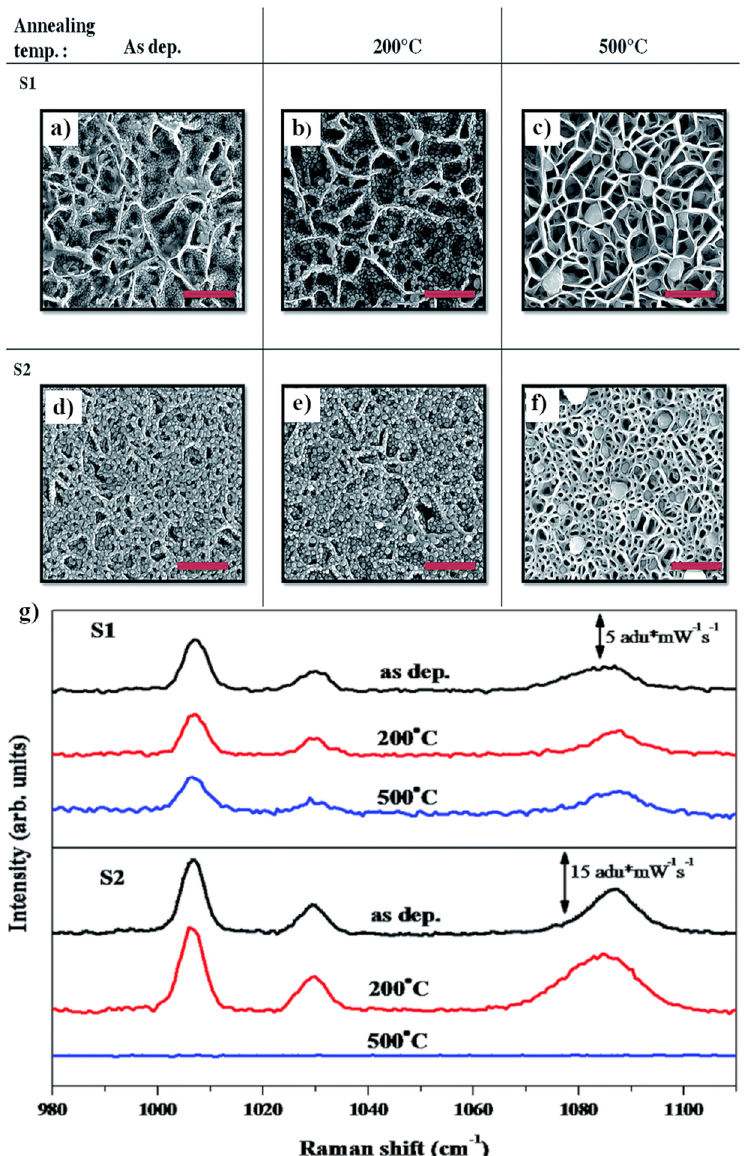
Figure 6. SEM images of GaN nanowalls covered with silver: less densely packed (S1) and more densely packed (S2). ( a , d ) Without annealing, ( b , e ) after annealing at 200 °C, ( c , f ) after annealing at 500 °C. ( g ) SERS spectra for substrates S1 and S2. Thiophenol was used as a test molecule. Reprinted with permission from [38]. Copyright 2015 Royal Society of Chemistry.